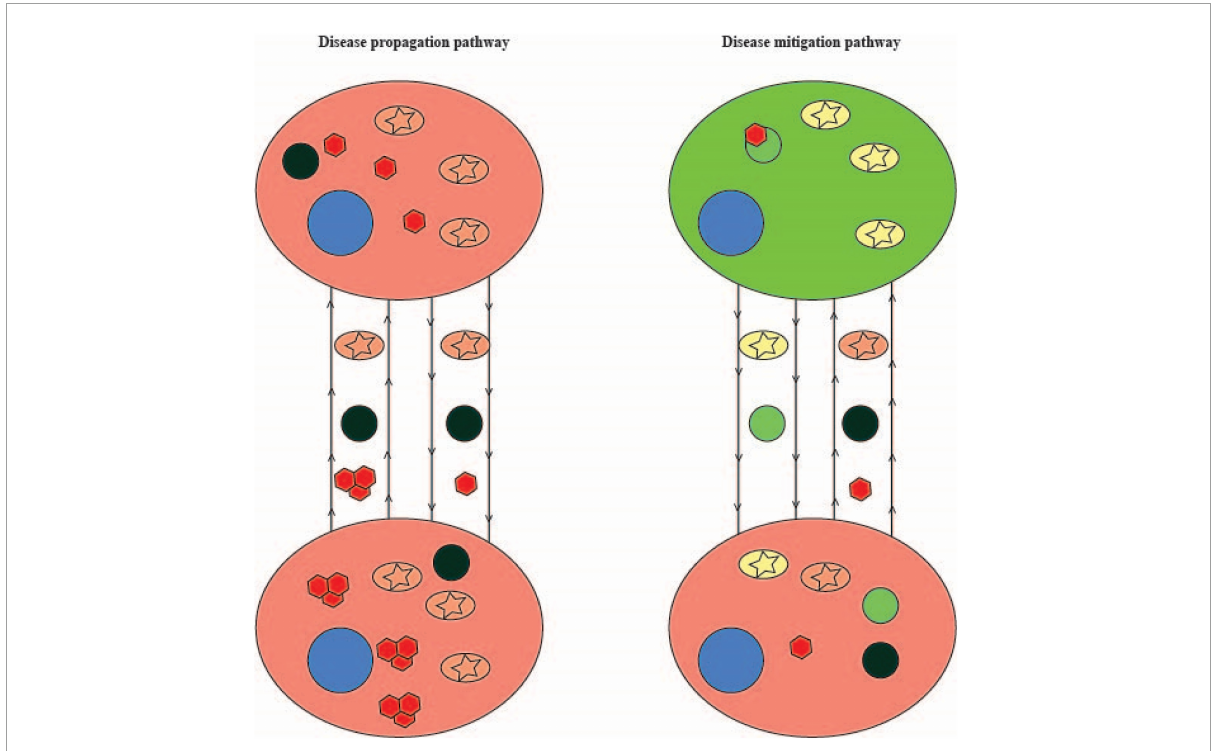
FIGURE2 A model of the role that TNTs may play in neurodegeneration. On the left are two disease cells (red circles) undergoing neurodegeneration and connected by TNTs. TNTs shuttle dysfunctional mitochondria (pink circles with stars), dysfunctional lysosomes (dark green circles), and aggregation-prone proteins (red hexagons) between cells. The accumulation of aggregation-prone protein in disease cells leads to seeding and enlargement of aggregates (depicted by three adjacent red hexagons). On the right is a healthy cell (large light green circle) connected to a disease cell (red circle) by TNTs. The disease cell shuttles dysfunctional mitochondria, dysfunctional lysosomes and aggregation-prone proteins to the healthy cell. The healthy cell degrades the aggregation-prone proteins in lysosomes and shuttles healthy lysosomes (light green small circles) and mitochondria (yellow circles with stars) to the disease cell. As a result, the disease cell is able to manage its load of aggregation-prone protein. Nuclei are depicted with blue circles and arrowheads reflect the direction of